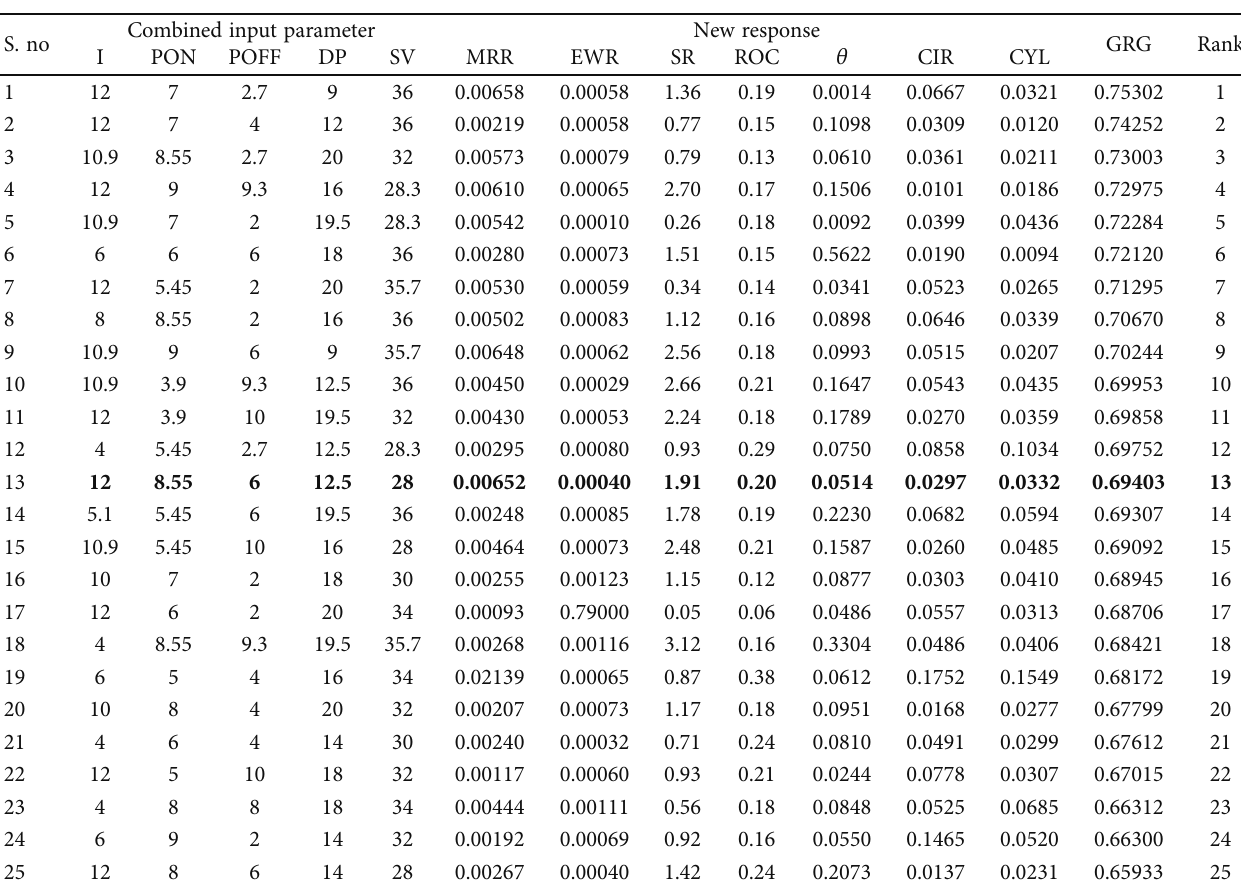
Table 11: Candidate solution based on the nondominance